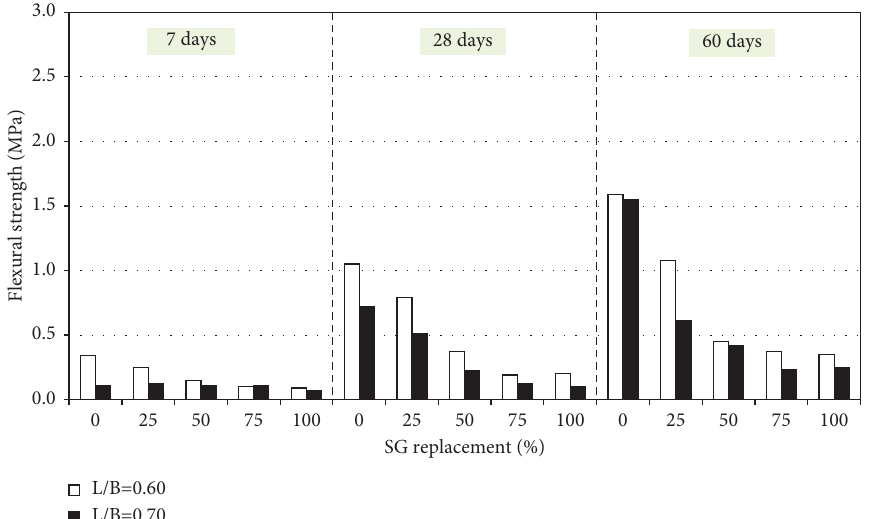
Figure 6: Flexural strength of AAFA mortar containing RG under diferent curing times and L/B